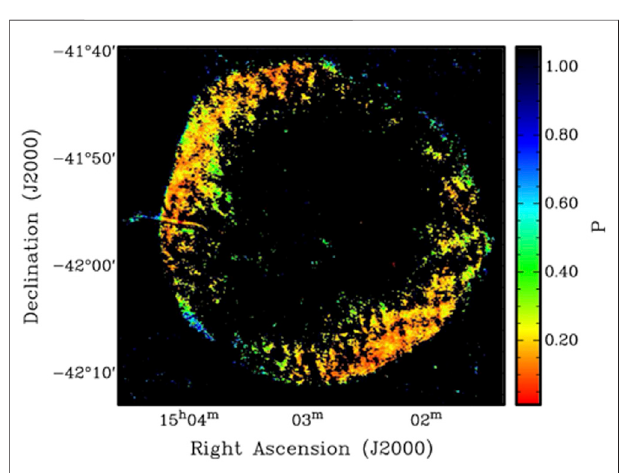
FIGURE 3 | Fractional polarization of SN 1006 at 1.4 GHz. The resolution is 10 arcsec. Only pixels where p was at least twice its error were kept. This fi gure is taken from Reynoso et al. (2013, The Astronomical